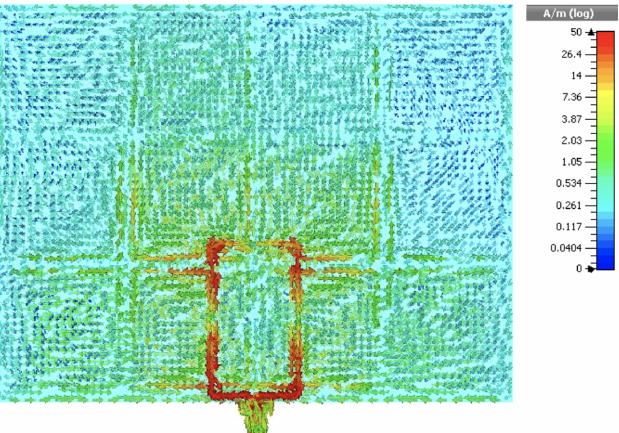
Figure 21. Snaphot of the electric surface current distribution at the surface of wearable loop antenna with HIS structure, computed at a frequency of 2.5 GHz.